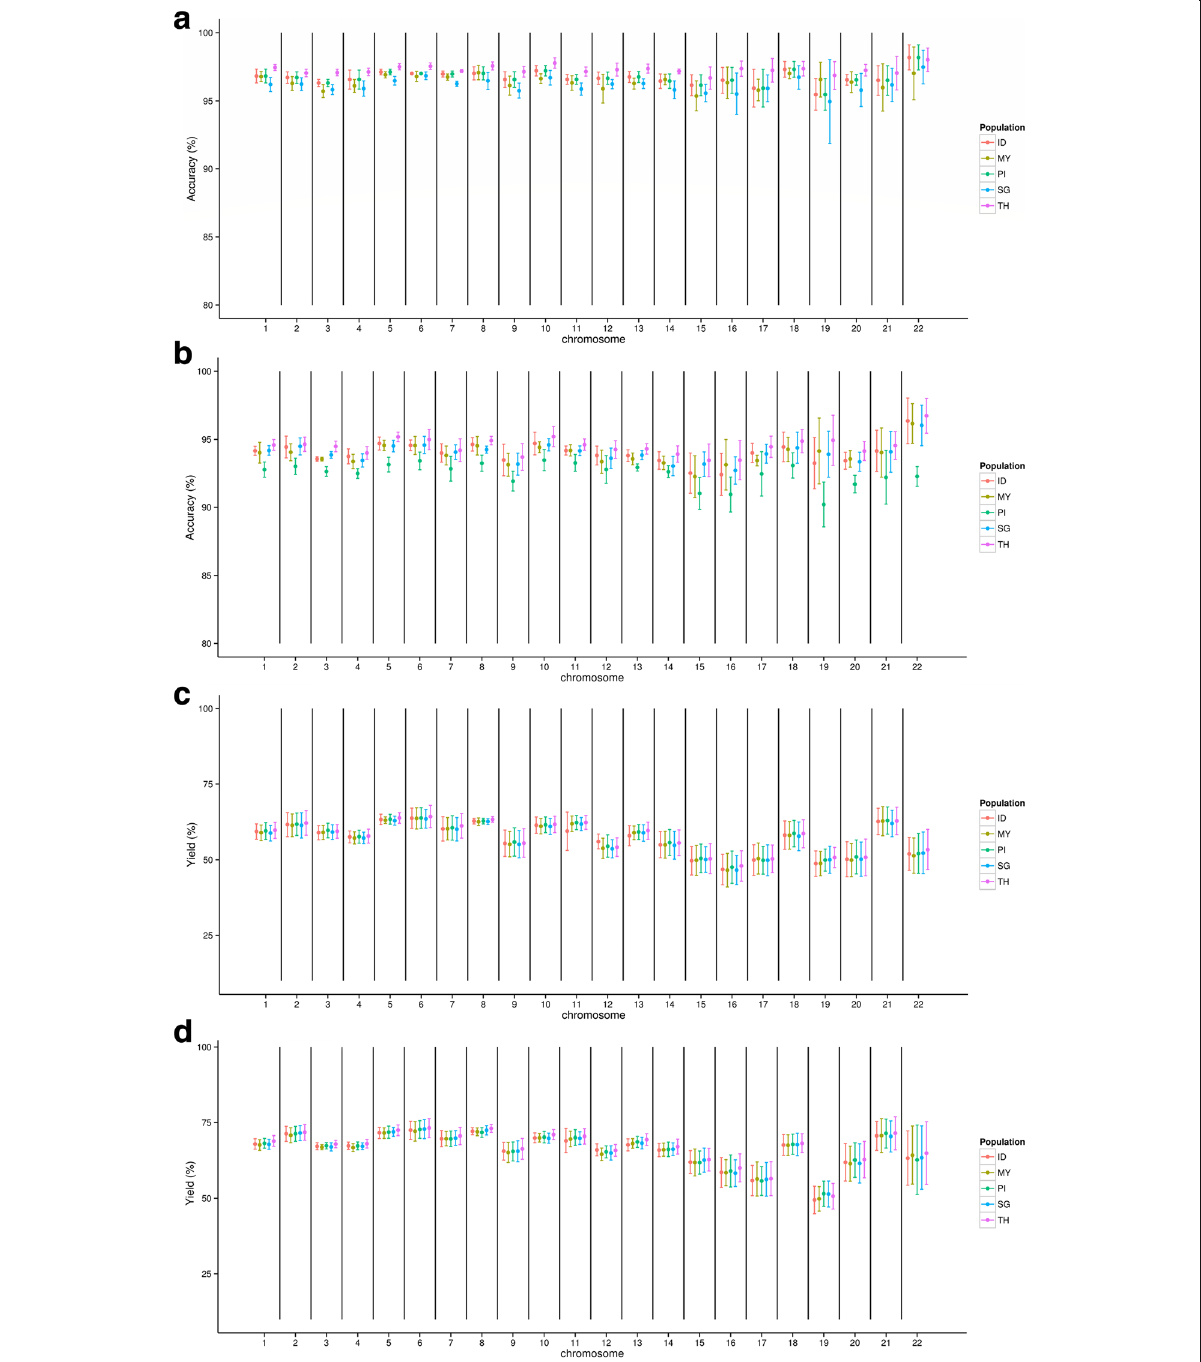
Fig. 2 Imputation accuracy and yield by chromosome. The results derived from 5% randomly removed SNPs. Imputation with IMPUTE2 was accomplished to recover the removed SNPs. The imputed SNPs were tested for accuracy with previously removed SNPs. The same set of the removed SNPs was applied to all population dataset. This process was repeated five times. a Imputation accuracy by chromosome using HMII as a reference. b Imputation accuracy by chromosome using 1000G as a reference. c Imputation yield by chromosome using HMII as a reference. d Imputation yield by chromosome using 1000G as a reference. Abbreviations: Indonesia (ID), Malaysia (MY), the Philippines (PI), Singapore (SG), and Thailand